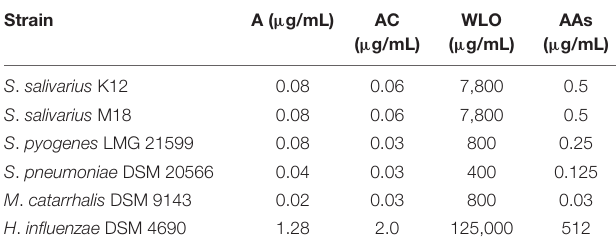
TABLE 2 | MIC values obtained for all tested